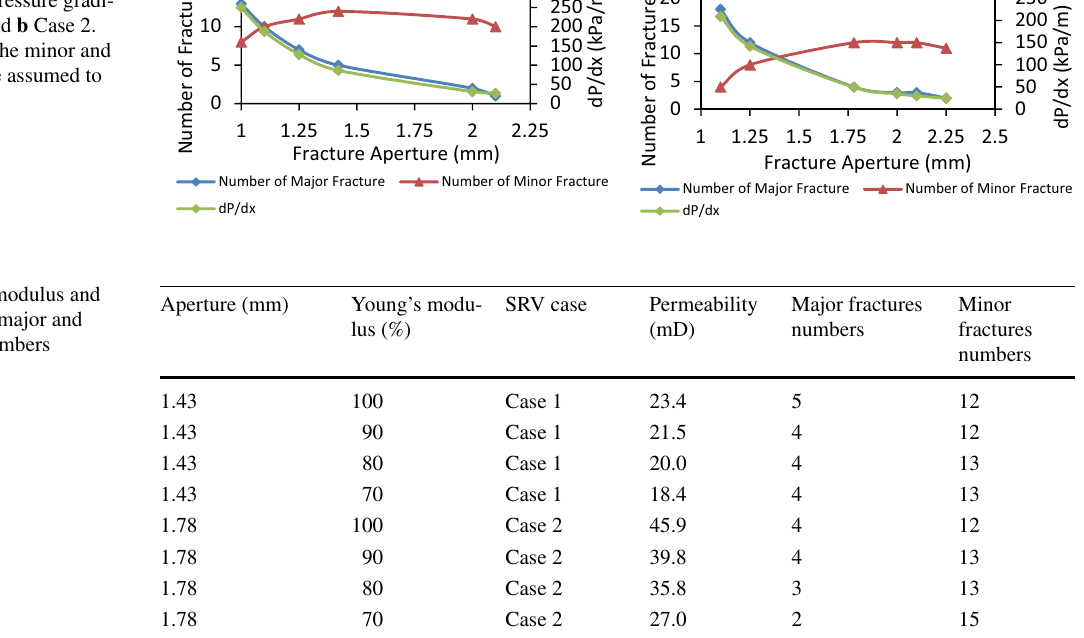
Fig. 17 Relationship among fractures number, fracture aper- ture and fracture pressure gradi- ent for a Case 1 and b Case 2. The apertures for the minor and major fractures are assumed to be equal